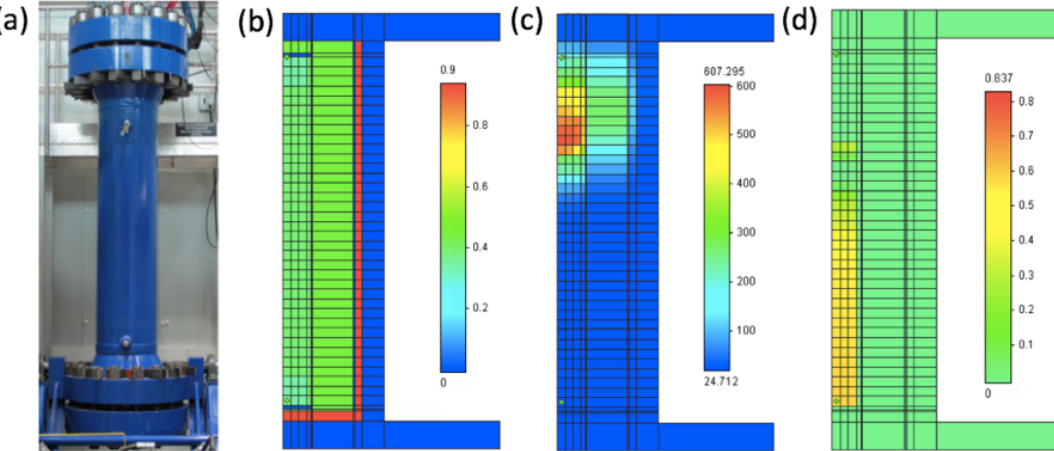
Figure 3. MPCT Installation (a) and the numerical model of the MPCT in CMG STARS: initial porosity (b) , temperature distribution over time (c) , oil saturation distribution over time (d)